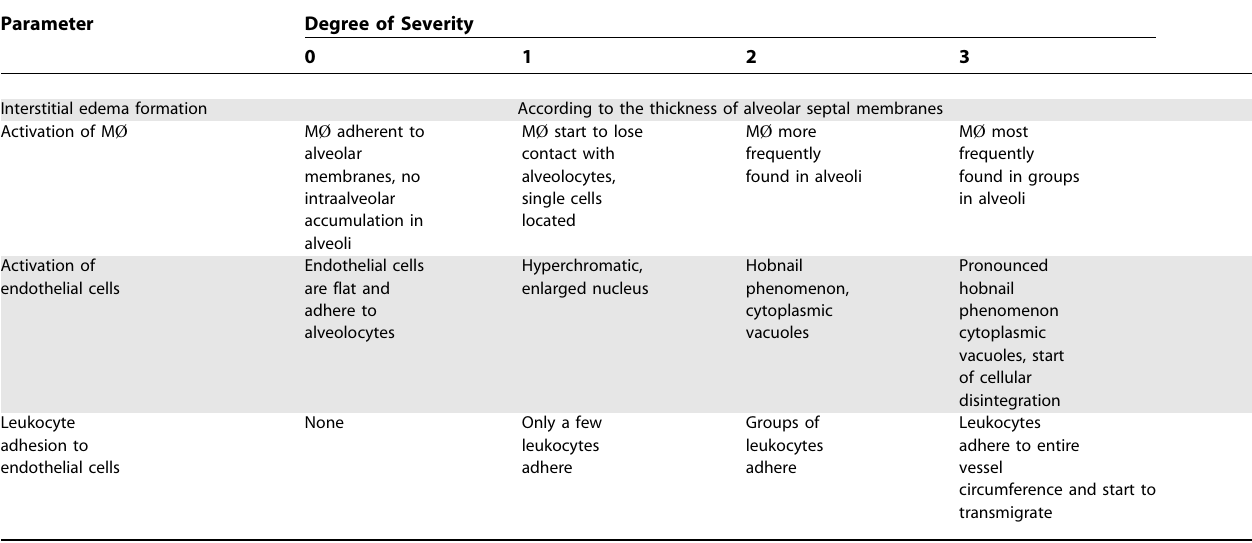
Table 1. Determination of Lung Injury Score